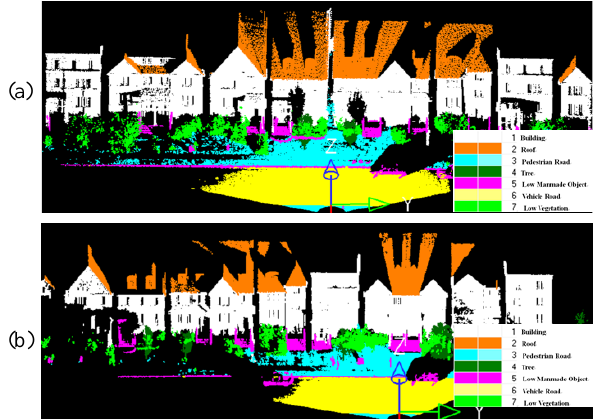
Figure 5. Ground truth of the Site A (a) and Site B (b).